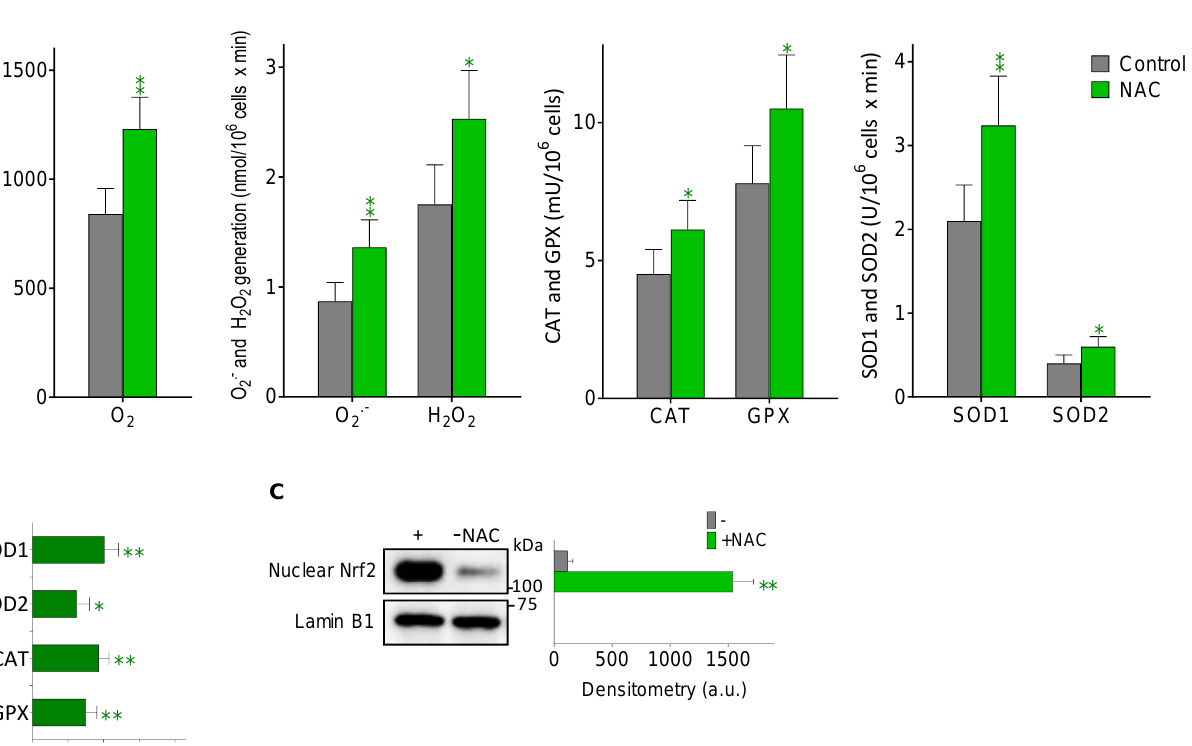
Figure 4. Effect of NAC treatment on the generation of ROS in metastatic B16-F10 cells. Melanoma cells were inoculated, mice treated, and metastatic cells isolated as in Table 2. ( A ) O 2 consumption, ROS generation and oxidative stress-related enzyme activities (n = 5–6). ( B ) Expression of oxidative stress-related enzymes. Data express fold change (quantitative RT-PCR) (n = 5–6) comparing metastatic cells from NAC-treated mice versus controls. Significantly different * p < 0.05, ** p < 0.01. ( C ) Western blot analysis of the effect of NAC treatment on nuclear Nrf2. Densitometric analysis represents the mean values ± SD for three different mice and experimental condition (** p < 0.01, comparing NAC-treated mice versus controls).